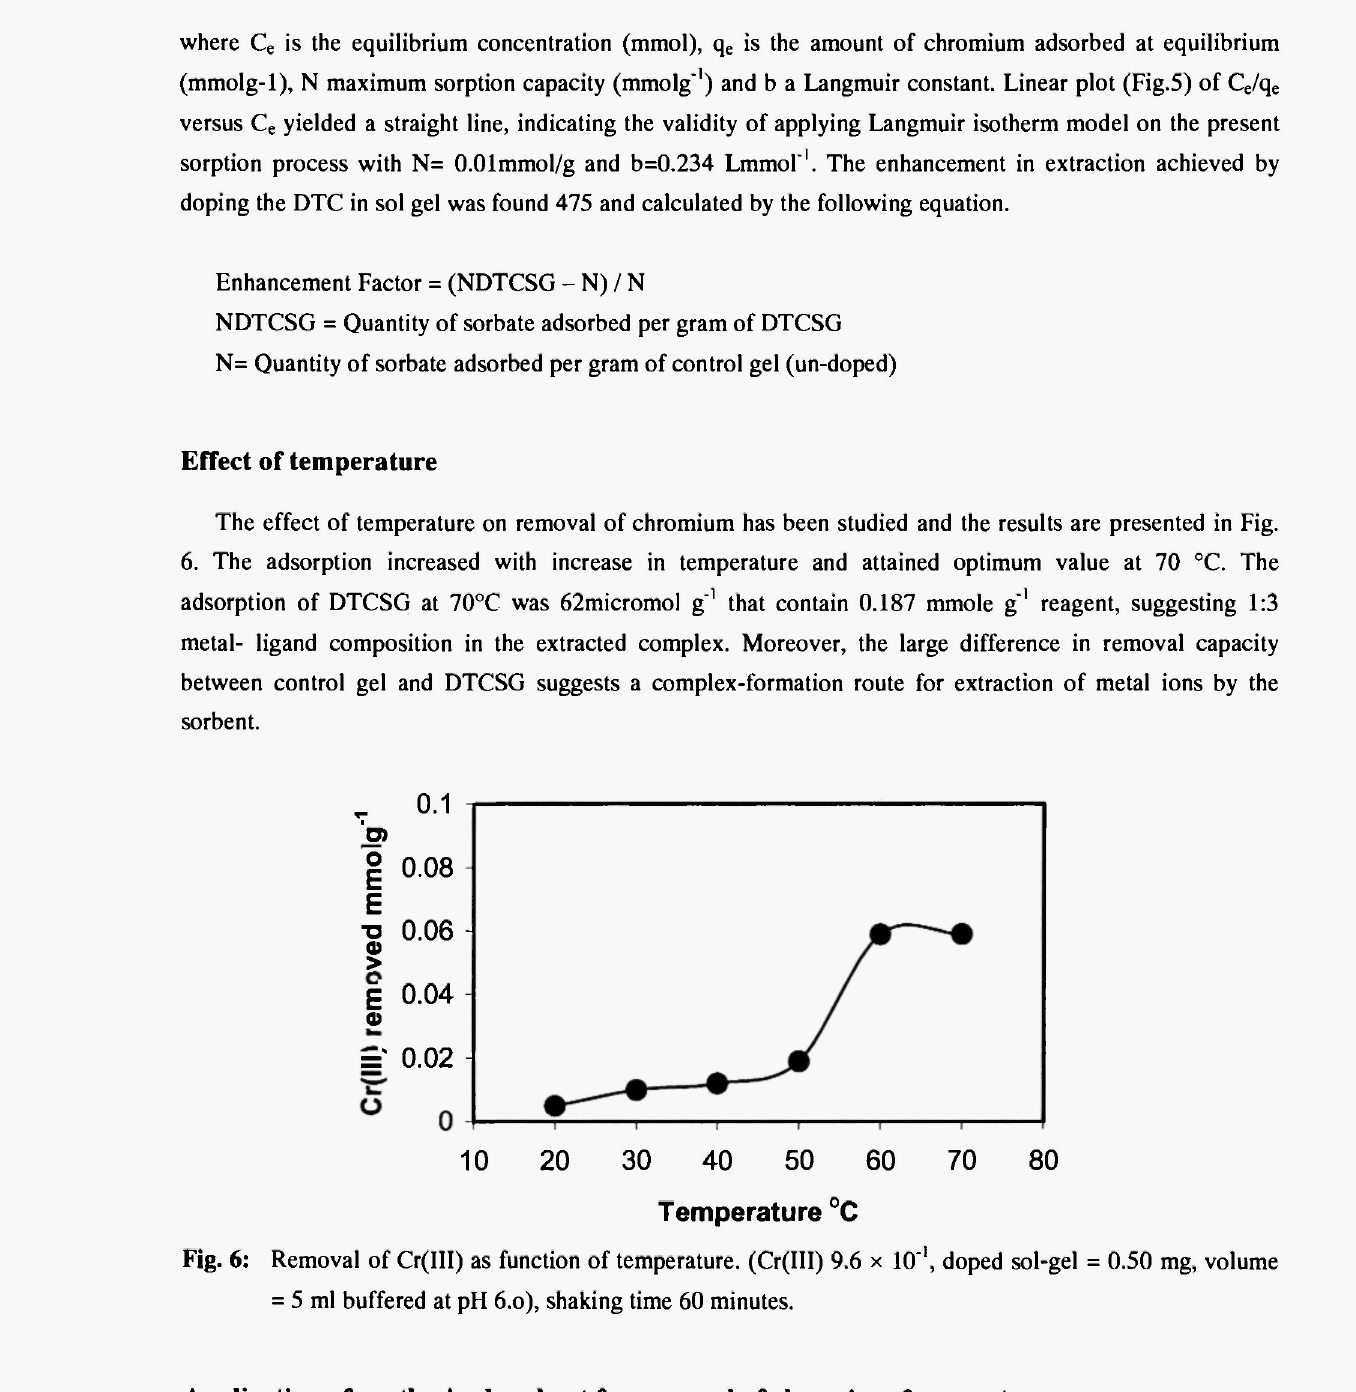
Fig. 6: Removal of Cr (III) as function of temperature. (Cr (III) 9.6 χ 10"', doped sol-gel = 0.50 mg, volume = 5 ml buffered at pH 6.o), shaking time 60